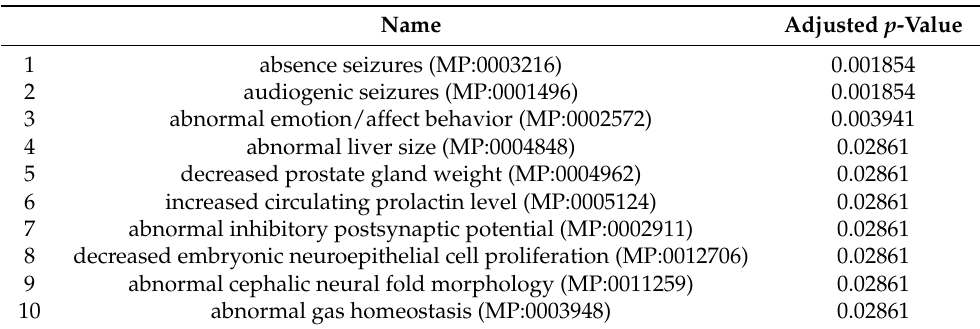
Figure 1. Gene Ontology analysis of the DEP list of 2-week L-NAME-untreated and -treated hippocampal tissue of C57BL/6 mice. Top 10 most significant GO hits for biological process (green bars), molecular function (blue bars), and cellular component (red bars). The y -axis depicts GO terms with their associated GO-ID, and the x -axis the associated − log10 ( p -value). Then the mouse mammalian phenotypes associated with the DEP list (Table 2) were Table 3. Top 10 most significant MGI Mammalian Phenotype terms for the DEP list of 2-week L- retrieved from the MGI Mammalian Phenotype Level 4 2021 database. We found that our NAME-untreated and -treated hippocampal tissue of C57BL/6 mice. Terms are ranked by p -value from most significant to less